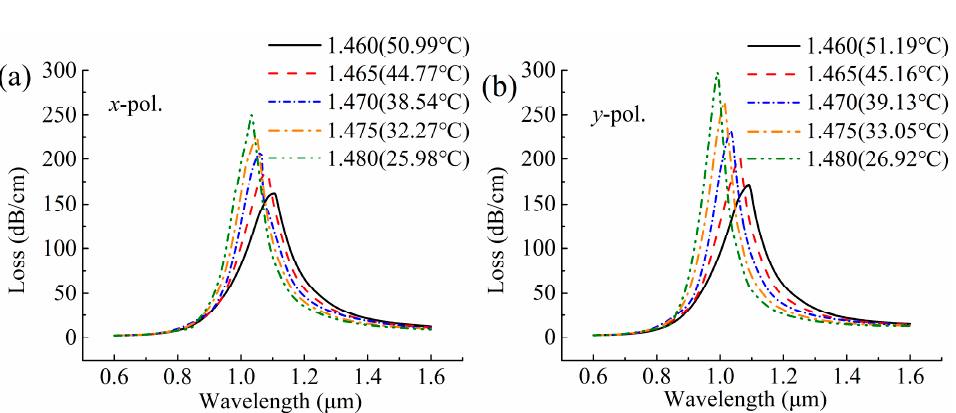
Figure 3. Losses as a function of wavelength for the ( a ) x -polarized and ( b ) y -polarized core modes at different n (temperatures).